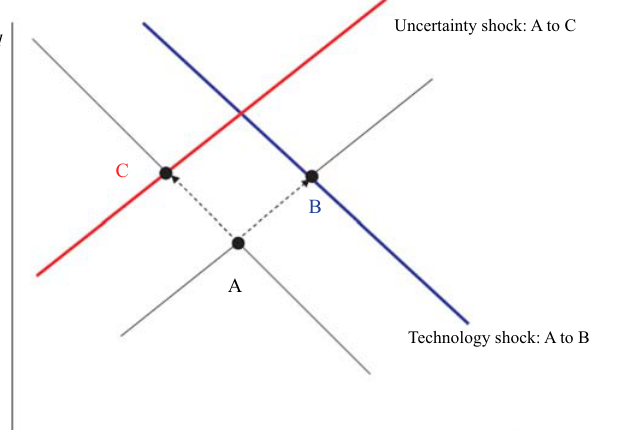
Figure 2. The partial equilibrium impact of an uncertainty shock